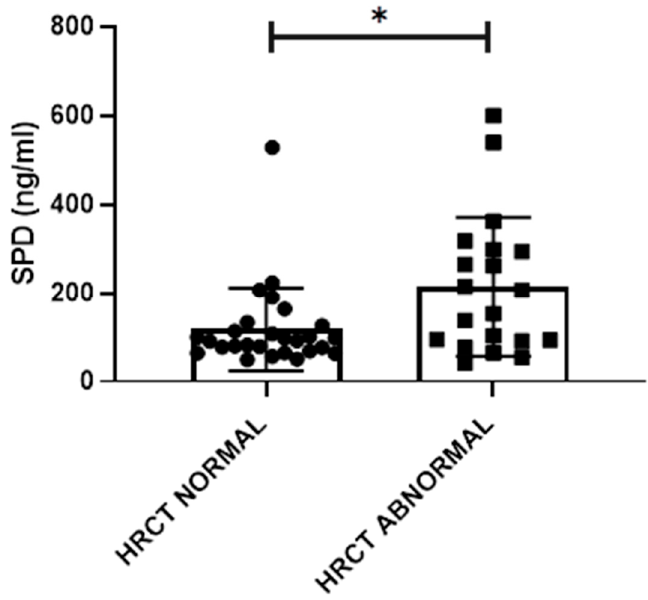
Figure 2. SPD serum levels in subjects with normal and abnormal HRCT. *: p < 0.05.